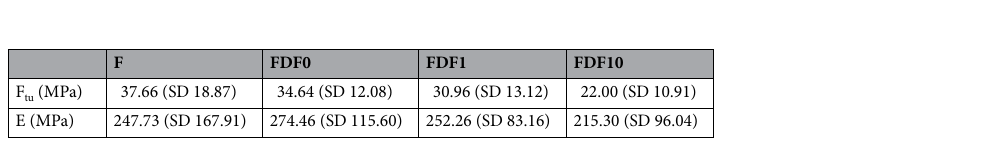
Table 2. A correct version of the original Table